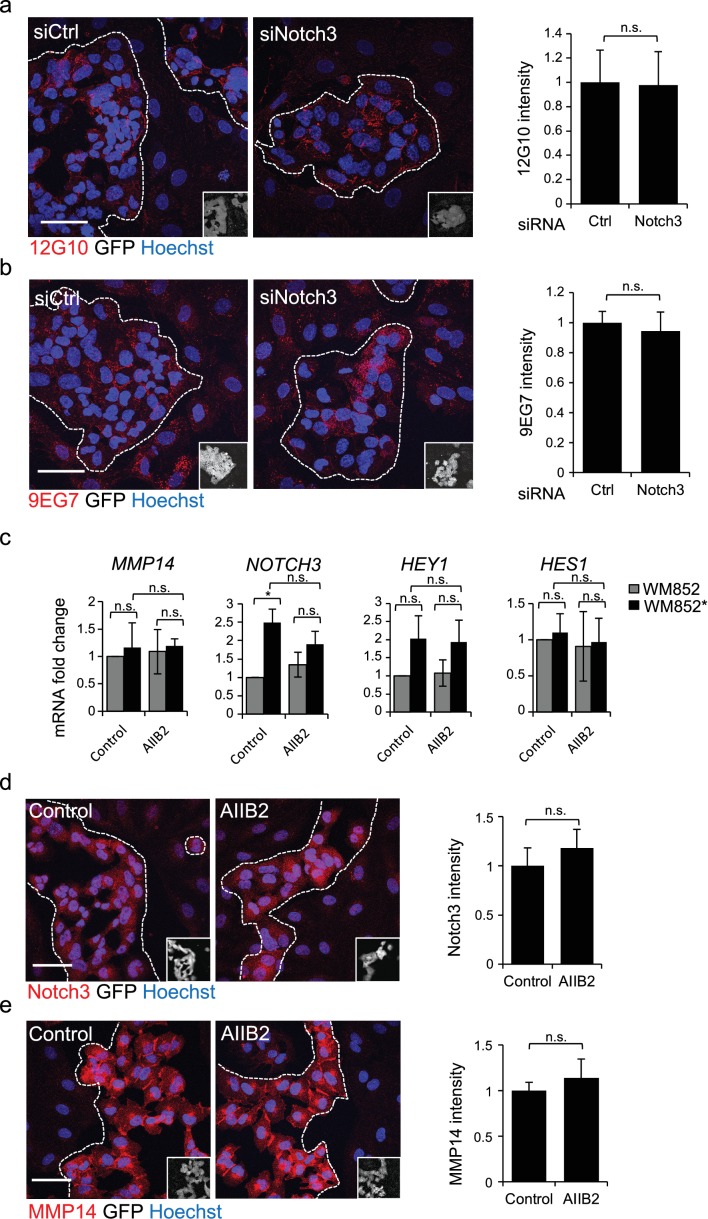
β1-integrin activity does not affect MMP14 and Notch3 expression.(a, b) Left and middle panels: representative confocal images of active β1-integrin expression using 12G10 (a) and 9EG7 antibodies (red) in WM852* cells treated with indicated siRNAs for 72 hr. Nuclei were counterstained with Hoechst 33342. GFP-expressing melanoma cells are shown white in the inset. The dashed line indicates the LEC-melanoma border. Scale bar = 50 µm. Right panels: Quantification of the average of 12G10 (a) and 9EG7 (b) signal intensities. Four images/condition were quantified from two independent experiments. More than 100 cells were always analysed per condition; error bars indicate SD. n.s., non-significant. (c) mRNA fold change of the indicated targets in WM852 and WM852* following treatment with AIIB2 β1-integrin blocking antibody for 48 hr and magnetic separation. Graphs show the average of two independent experiments, error bars indicate SD; *: p<0.05; n.s., non-significant. (d,e) Left and middle panels: Representative confocal images of control and AIIB2 β1-integrin blocking antibody treated WM852* cells stained with Notch3 (d, red), or MMP14 (e, red) antibodies. Nuclei were counterstained with Hoechst 33342. The dashed lines indicate the LEC-WM852 border (white, GFP positive WM852 cells in the inset) border. Scale bar = 50 µm. Right panels: Quantification of the average Notch3 (d) and MMP14 (e) signal intensity in WM852* (white) cells as described in (a,b); error bars indicate SD. n.s., non-significant. Full size confocal images are available as a source data 4.